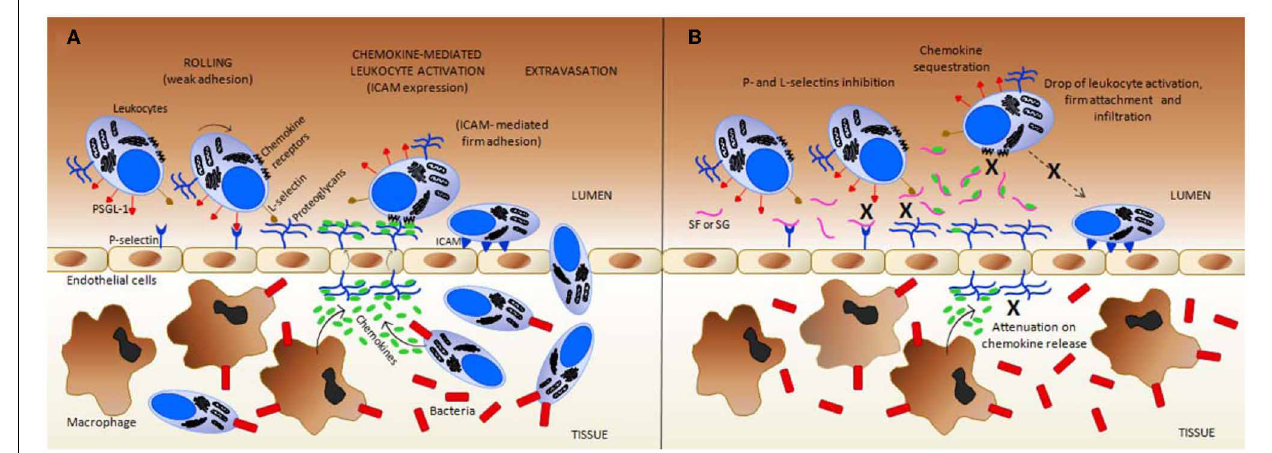
FIGURE 3 | Simplified scheme regarding the inflammation mechanisms in (A) normal (untreated) vs. (B) the treated condition with exogenous sulfated fucans (SFs) and sulfated galactans (SGs). These glycans can target multiple points during the inflammatory process. (A) In response to an inflammatory stimuli, such as a bacterial infection, resident macrophages in inner tissues produce both chemokines that attract more leukocytes into these inflamed tissues, and cytokines (such as tumor necrosis factor, TNF) that trigger, at the early stages, the display of pre-formed P-selectins on the luminal surface of endothelial cells (the cytokine-induced P-selectin exposure is not shown at the panels). Cytokines can also induce the expression of E-selectin by endothelial cells (mechanism not shown). GAGs at endothelial proteoglycans play an important role in L-selectin binding, in chemokine presentation to chemokine receptors on neutrophils, and in the transportation of chemokines produced by tissue macrophages and further infiltrated leukocytes. Intercellular adhesion molecule (ICAM), and P-selectin glycoprotein ligand-1 (PSGL) are important leukocyte cell-membrane proteins involved in rolling and firm adhesion, respectively. (B) In the presence of SFs,